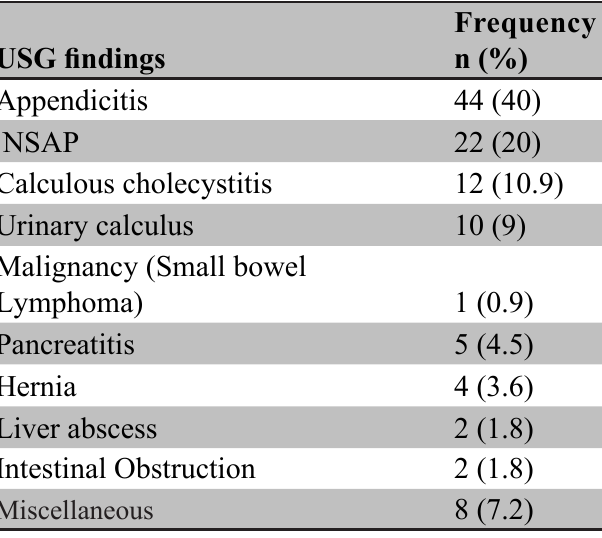
Table 2. Causes of acute abdomen based on USG findings (N=110).